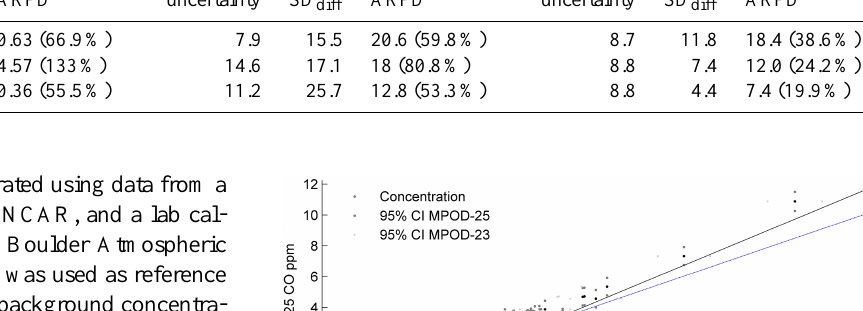
Table 3. Average pooled uncertainty calculations for user study duplicate measurements. CO (ppm) O 3 (ppb) NO 2 (ppb) Propagated Propagated Propagated uncertainty SD diff ARPD uncertainty SD diff ARPD uncertainty SD diff M-Pod 6, 9